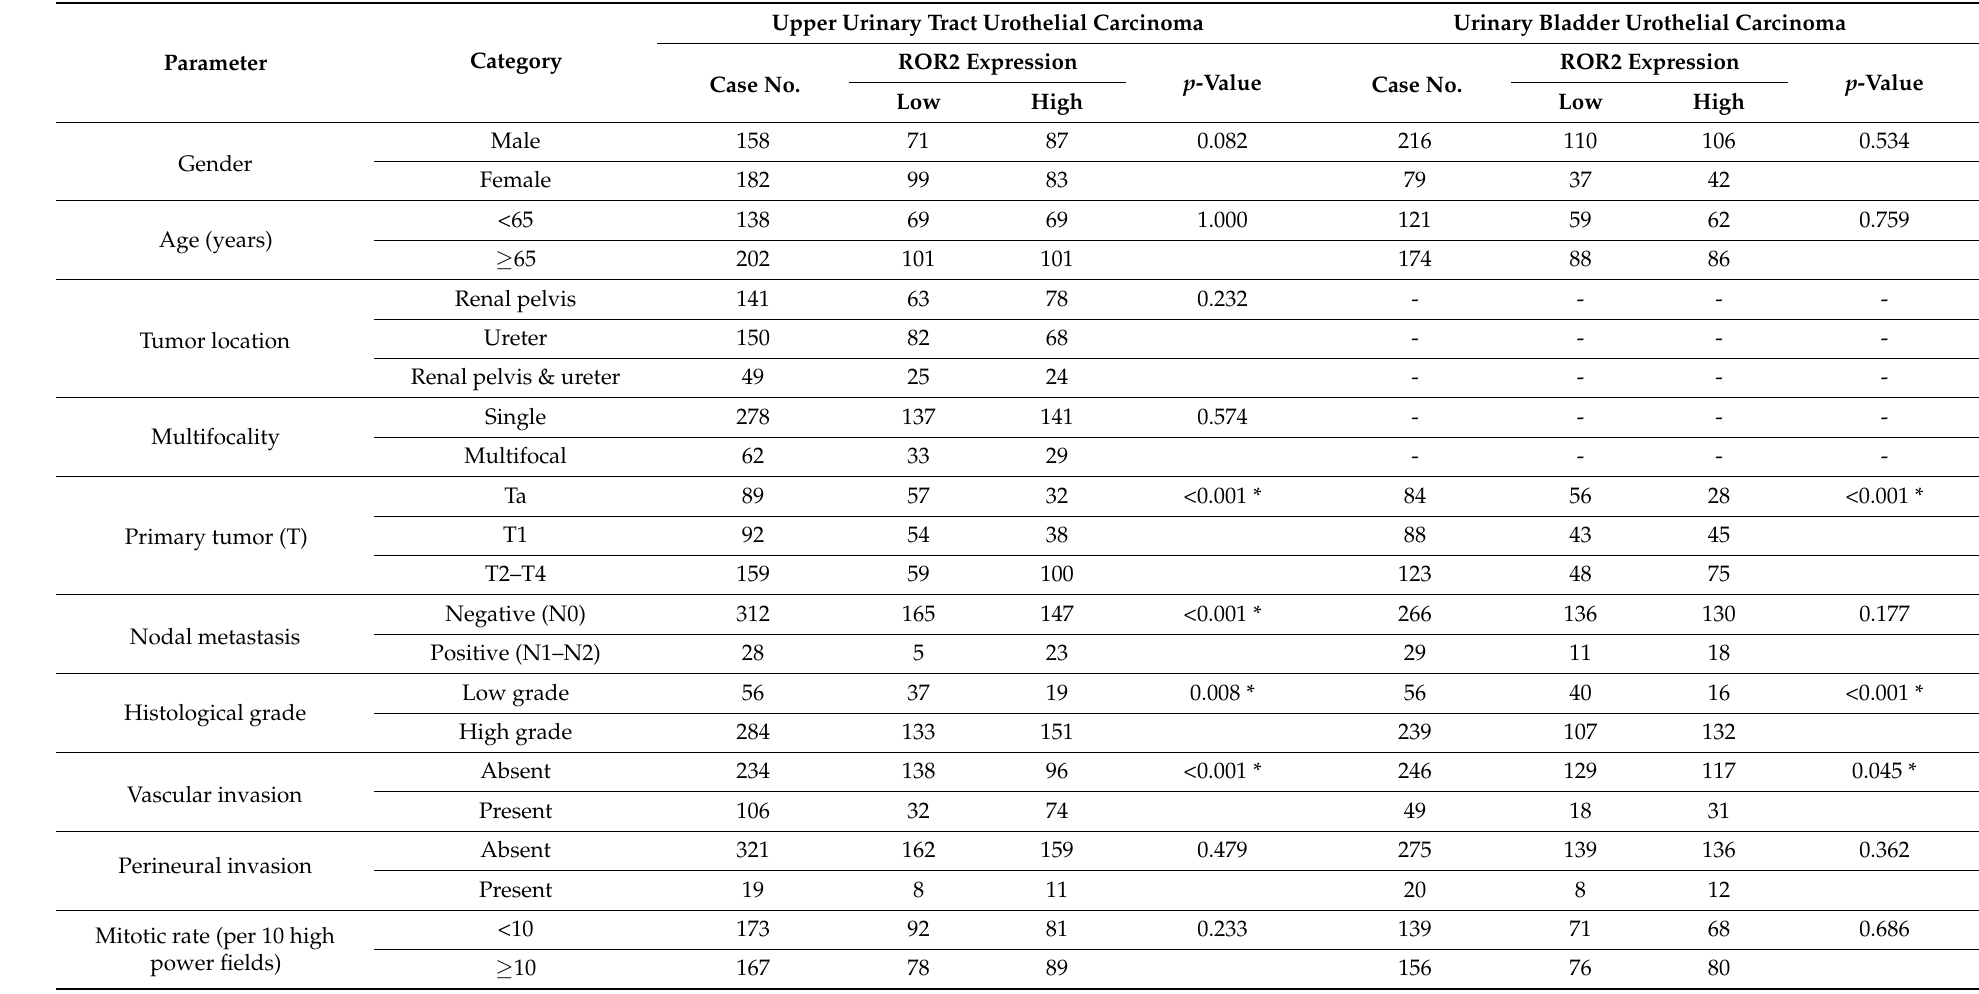
Table 2. Correlations between ROR2 expression and other important clinicopathological parameters in urothelial